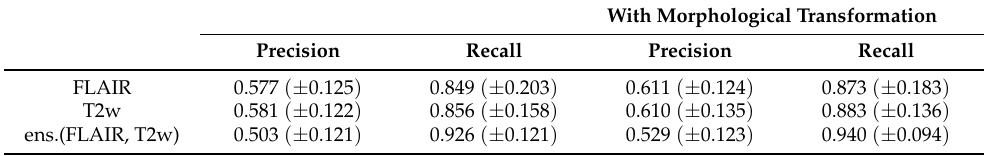
Table 3. Detection results on LGG test with 76 test patients. Results present the mean ± standard deviation.